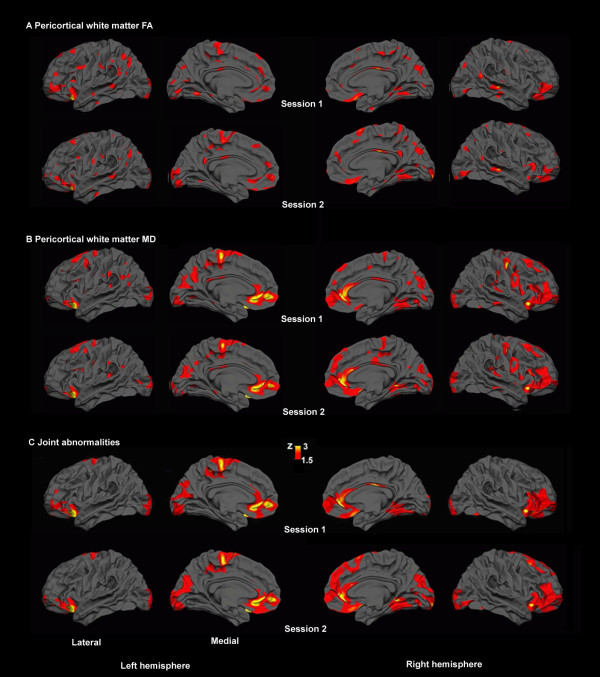
Pericortical white matter abnormalities. Regions of low anisotropy (A) and high diffusivity (B) were broadly distributed underneath the cortical mantle, with similar spatial distributions in both sessions (point-wise, z > 1.5, shown without the cluster threshold).